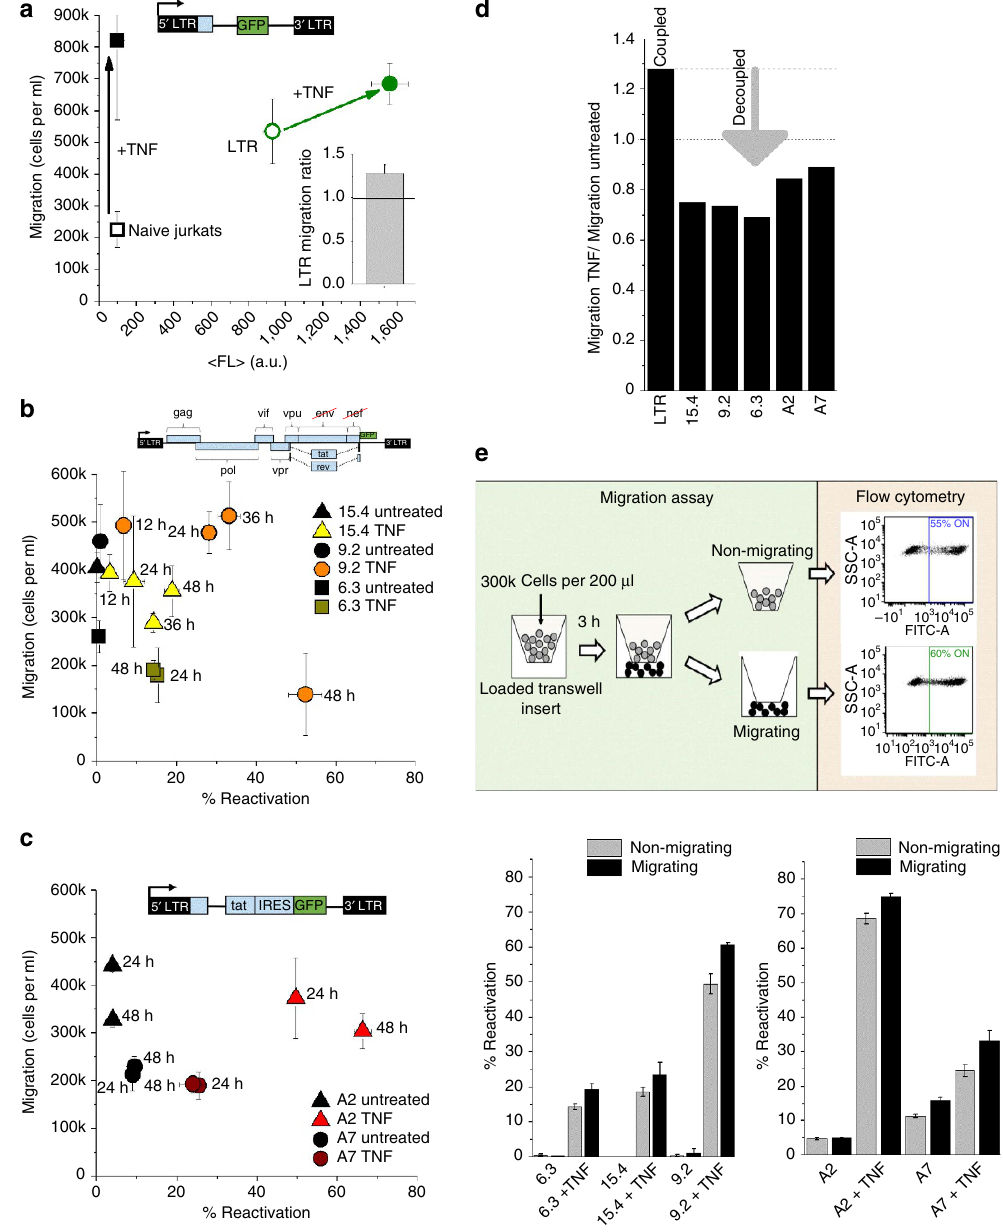
Figure 4 | Migration in reactivated cell populations harbouring latent HIV. ( a ) HIV LTR–GFP displays correlated gene expression as measured by mean fluorescence ( o FL 4 ) and migration after 24h TNF. Naive Jurkat cells show only an increase in migration with TNF. (Inset) Correlated migration increase with TNF is alternatively shown using an average ratio of TNF-treated migration by untreated migration. This calculation accounts for 18 migration measurements of LTR–GFP Jurkats used as a positive control for each experiment. The s.e. is plotted as well. ( b ) Upper: to test migration of latent cells infected with full-length HIV, the Jurkat latency (JLat) model was used. Lower: migration and reactivation of three clonal JLat populations of latent HIV under 12–48h TNF treatments. All three clones reveal decreased or constant migration with increasing reactivation. The untreated samples of the isoclones 9.2 and 15.4 were measured after 12h, whereas the untreated sample of isoclone 6.3 was taken after 24h. ( c ) To test migration and reactivation of Tat-expressing T-cells, a minimal viral circuit with HIV-1 LTR promoter driving Tat, internal ribosome entry site (IRES) and GFP was used (LTR-Tat-IRES–GFP or LTIG) 41 . Migration and reactivation of two clonal LTIG populations (A2 and A7) was measured after 24 and 48h of TNF treatment. All clones show a decrease or constant migration with increasing reactivation compared to the promoter only case ( a ). This result is consistent with Tat decoupling of migration by inhibiting CXCR4 on the cell membrane for an inverse or constant migration–reactivation relationship. ( d ) Normalized migration of TNF treatment by untreated migration post 24h shows a coupled phenotype with LTR–GFP and a decoupling caused by Tat reactivation of JLat and LTIG latent clones. ( e ) Upper: reactivation measurements of migrating and non-migrating cells for different JLat clones in the upper (non-migrating) and lower (migrating) wells of a transwell migration plate after 48h TNF using flow cytometry. Lower: migrating cells consistently reactivate more compared with non-migrating cells after 48h TNF treatment. All migration and reactivation experiments were carried out in duplicate or triplicate and independently on different days. The average values and s.e. for separate duplicates and triplicates are